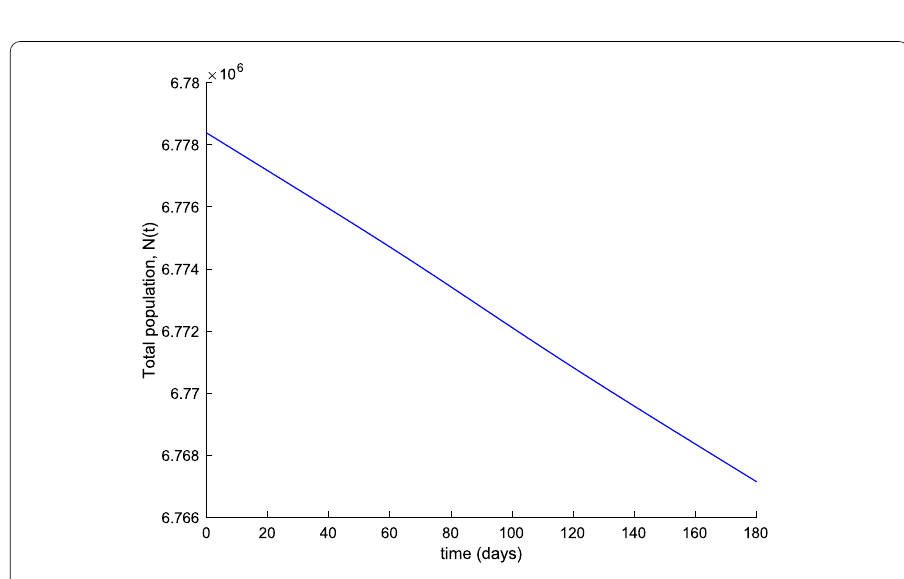
Figure 8 Evolution of the total population when vaccination is applied and no treatment is used. The vaccination gain is set to k V = 0.001